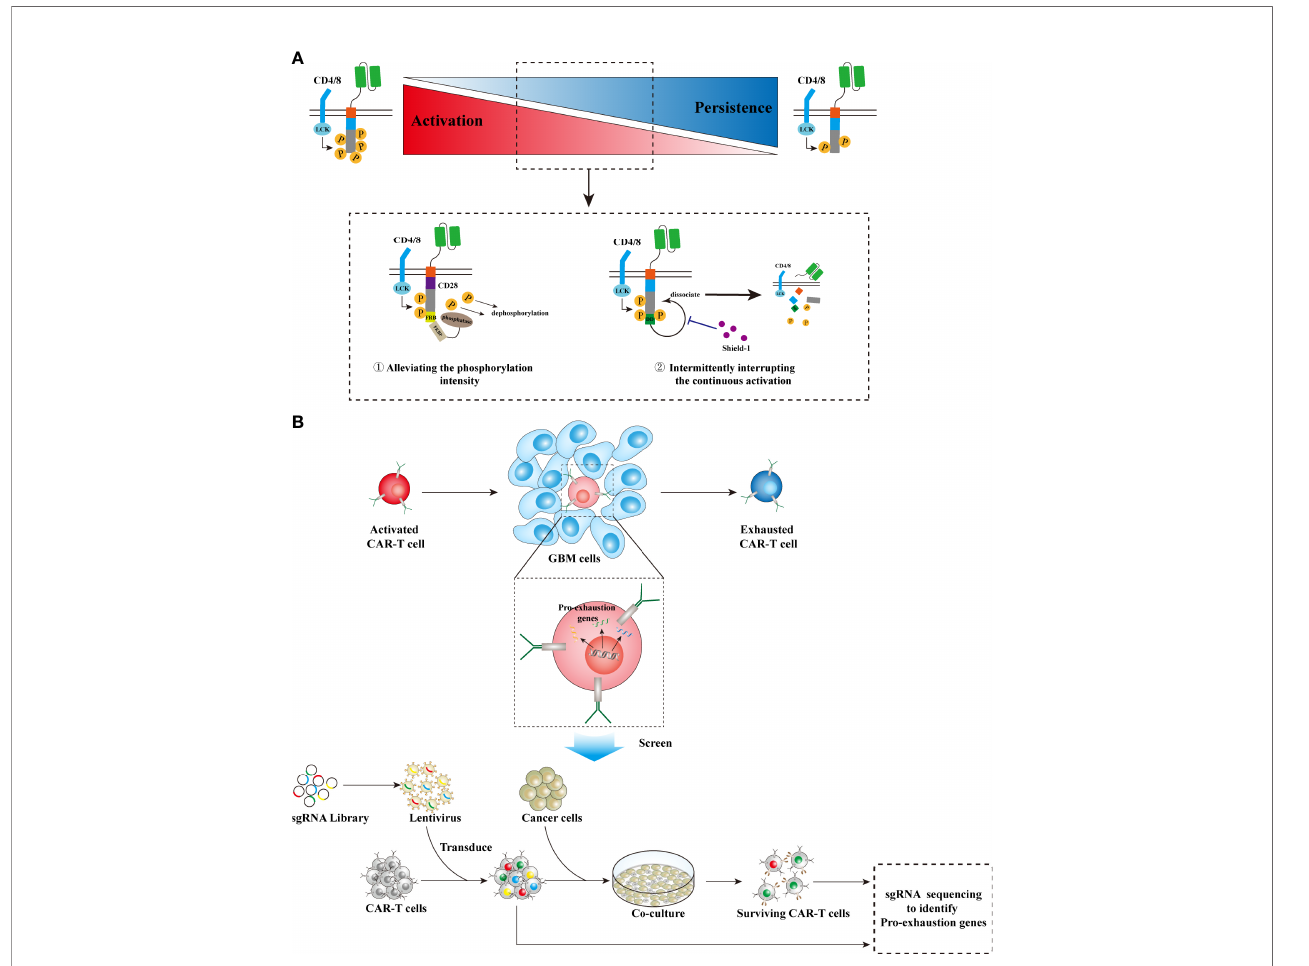
FIGURE 4 | Strategies to prolong CAR-T cell persistence. (A) Tuning inherent signaling. High phosphorylation intensity in TCR signaling leads to robust but unsustainable antitumor activity, while alleviating the phosphorylation intensity results in reduced but sustained tumor-killing effects. Two strategies can be utilized in CAR design to tune the phosphorylation intensity, thereby prolonging CAR-T cell persistence while maintaining moderate antitumor activity: ① Integrating CD28-CARs with the FRB domain, which recruits phosphatases via binding FKBP and then decreases the phosphorylation level, can suppress CAR overactivation. ② Intermittently administering a small molecular drug, shield-1, to interrupt the dissociation effect on CARs by the DD domain that is fused with CARs, will block CAR continuous activation. (B) Screening pro-exhaustion genes: GBM cells and their microenvironment can adaptively alter the gene expression pro fi les of in fi ltrative T cells into an exhausted phenotype, leading to shortened persistence. Identi fi cation of these pro-exhaustion genes via CRISPR-based genome-scale knockout technology will greatly accelerate CAR-T cell development to prolong persistence. LCK, leukocyte-speci fi c protein tyrosine kinase; FKBP, FK506 binding protein; FRB, FKBP-rapamycin binding; DD,